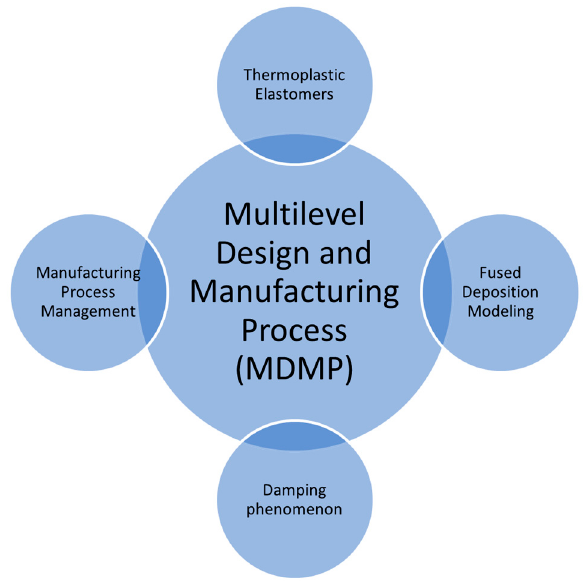
Figure 4. Multilevel design and manufacturing process components.